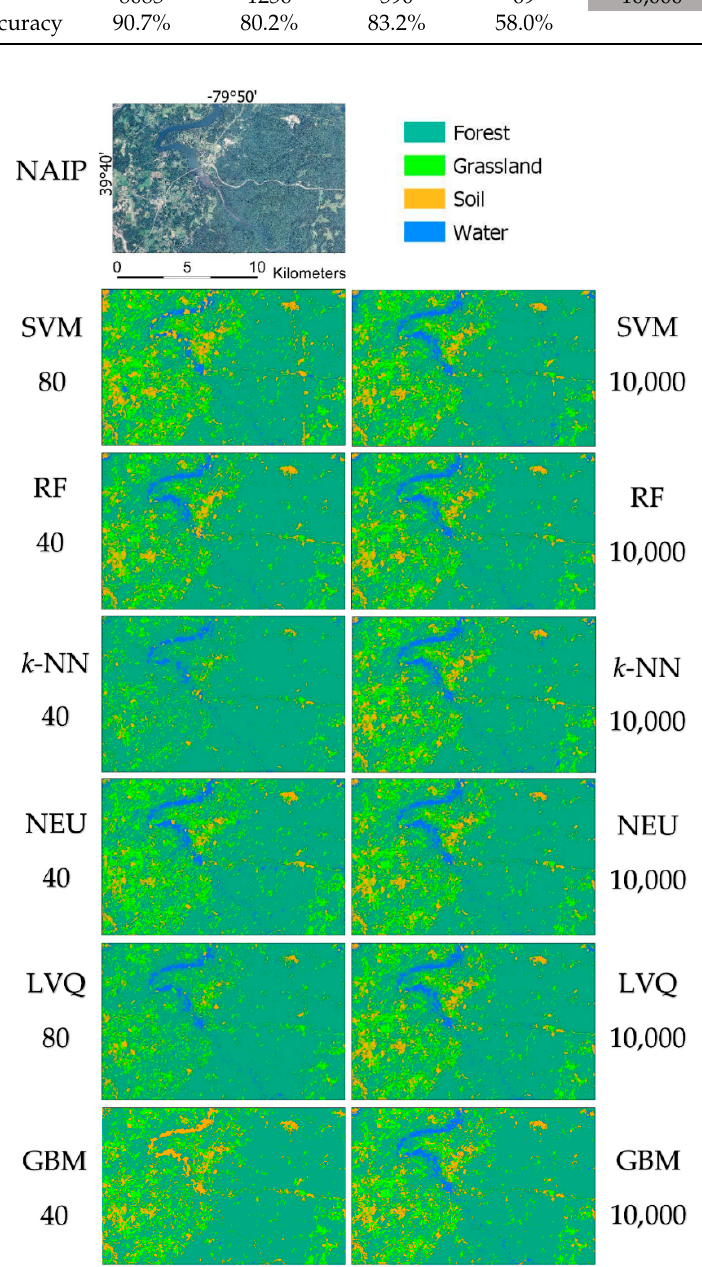
Figure 6. Example of land-cover classifications. The area depicted in this figure is highlighted as the blue region in Figure 1e. Land-cover classifications displayed are examples of the best and worst performing classifier, in terms of overall accuracy, of each classification method with a single iteration of classifications. The numbers below the classification method label (e.g., NEU) represent the number of training samples used.